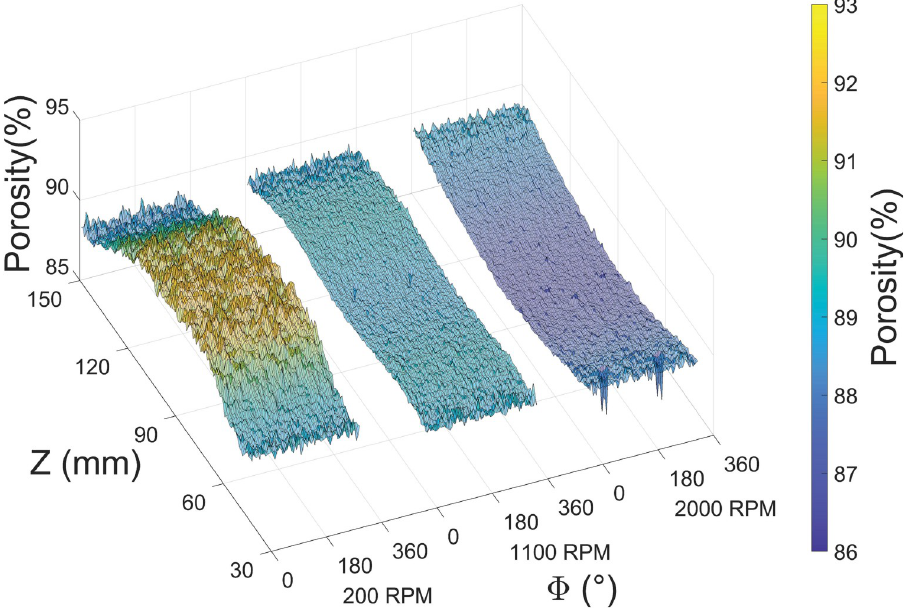
Fig 5. Porosity maps of example depositions on mandrels rotated at 200, 1100 and 2000 RPM plotted against both the azimuthal ( F , circumferential) and axial (Z, longitudinal) directions.